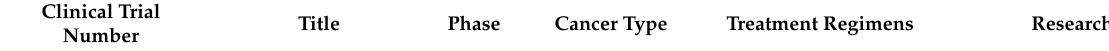
Table 3. On-going clinical trial with curcumin combined